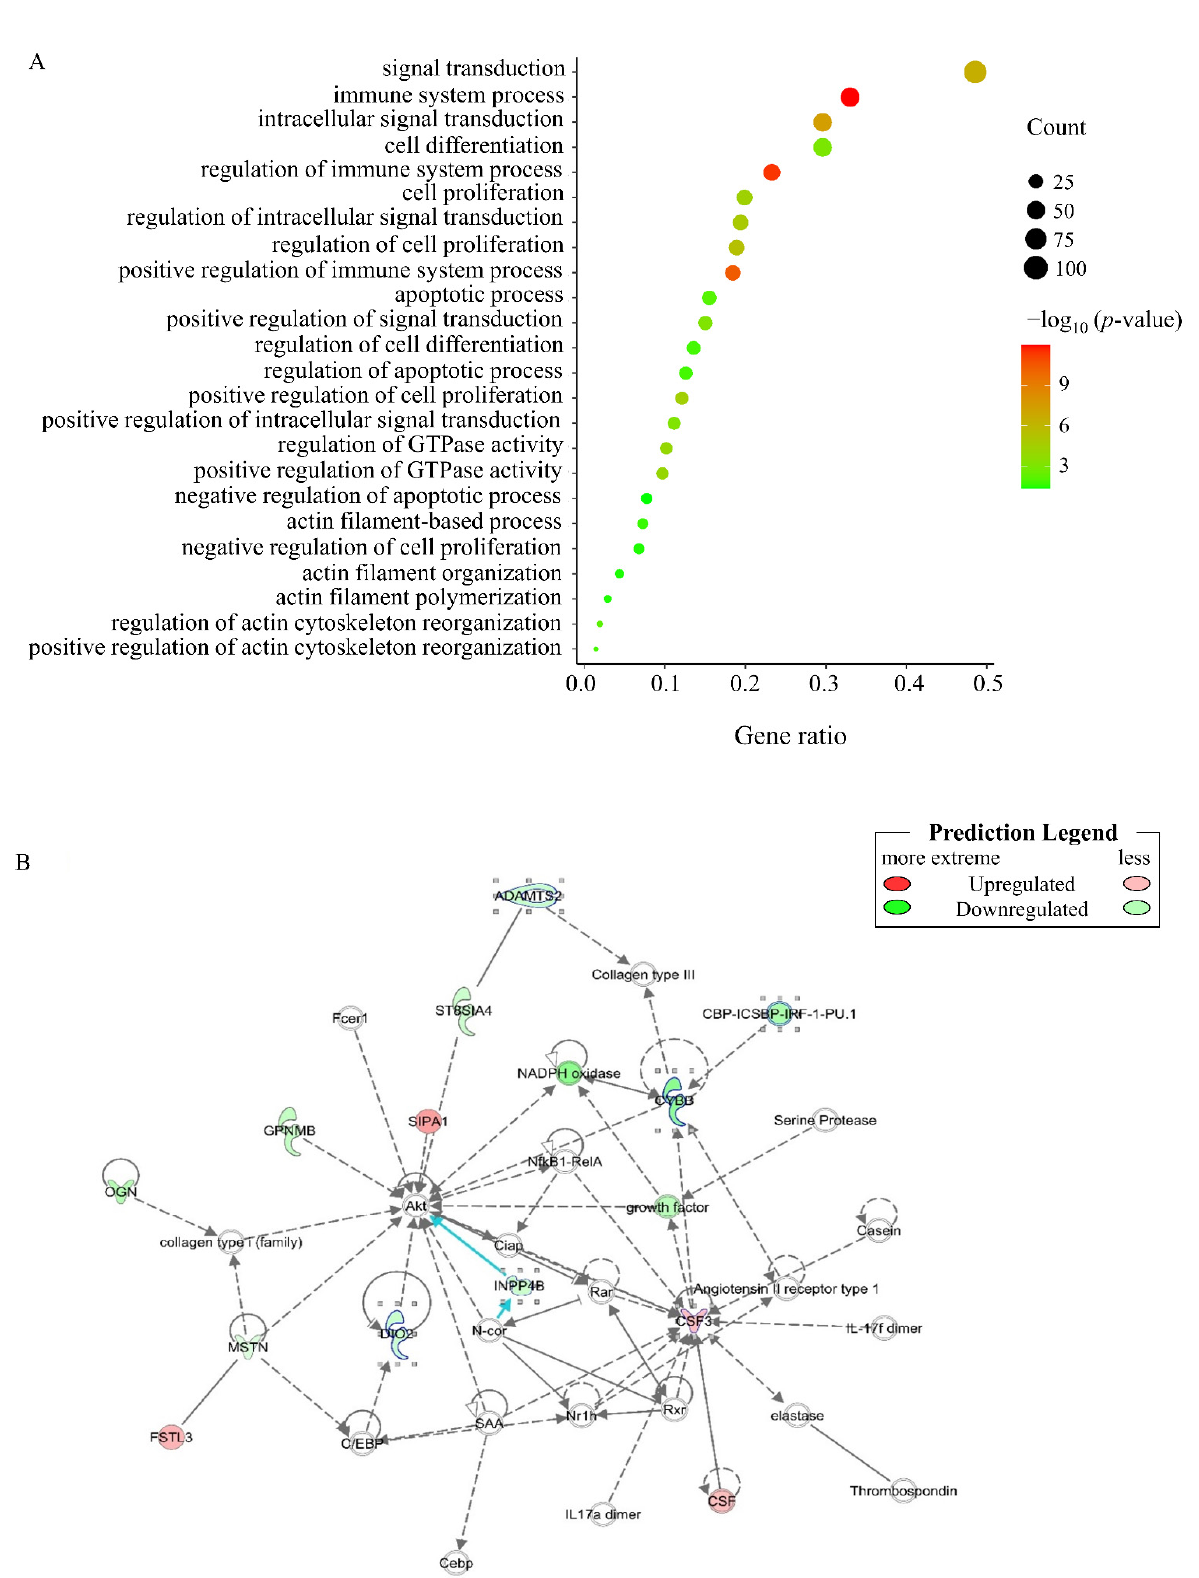
Figure 3. Representative enriched gene ontology (GO) terms and associated network of differentially expressed genes (DEGs) (CFM_KO vs. CFM_WT). ( A ) Representative enriched GO terms. ( B ) Gene network containing DEGs related to Connective Tissue Development and Function; Skeletal and Muscular System Development and Function; and Tissue